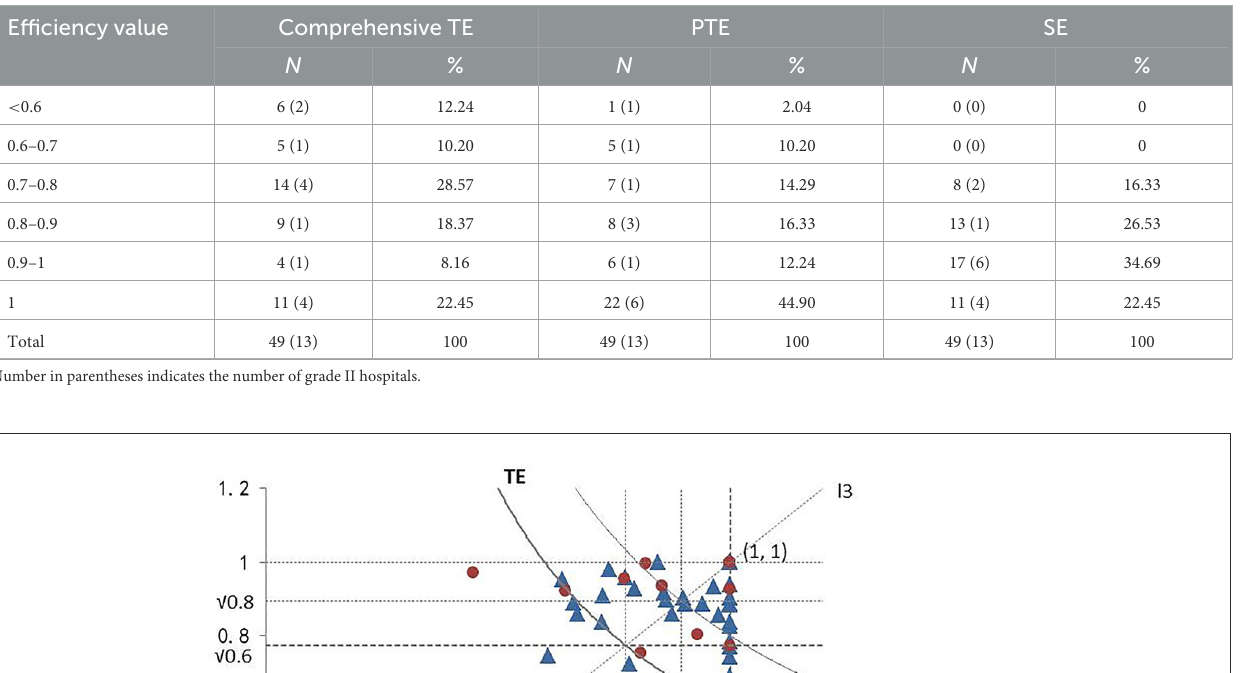
TABLE 6 Efficiency distribution of public hospitals in Fujian Province.